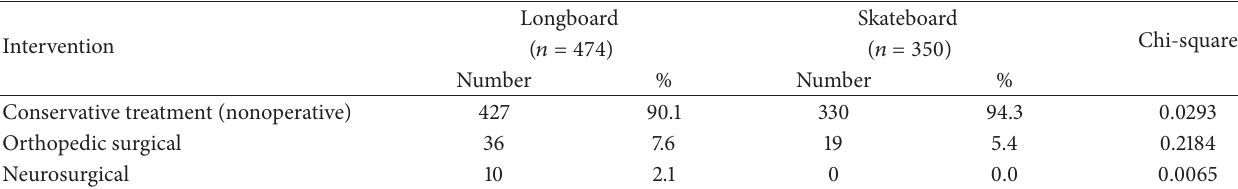
Table 4: Types of patient treatment.